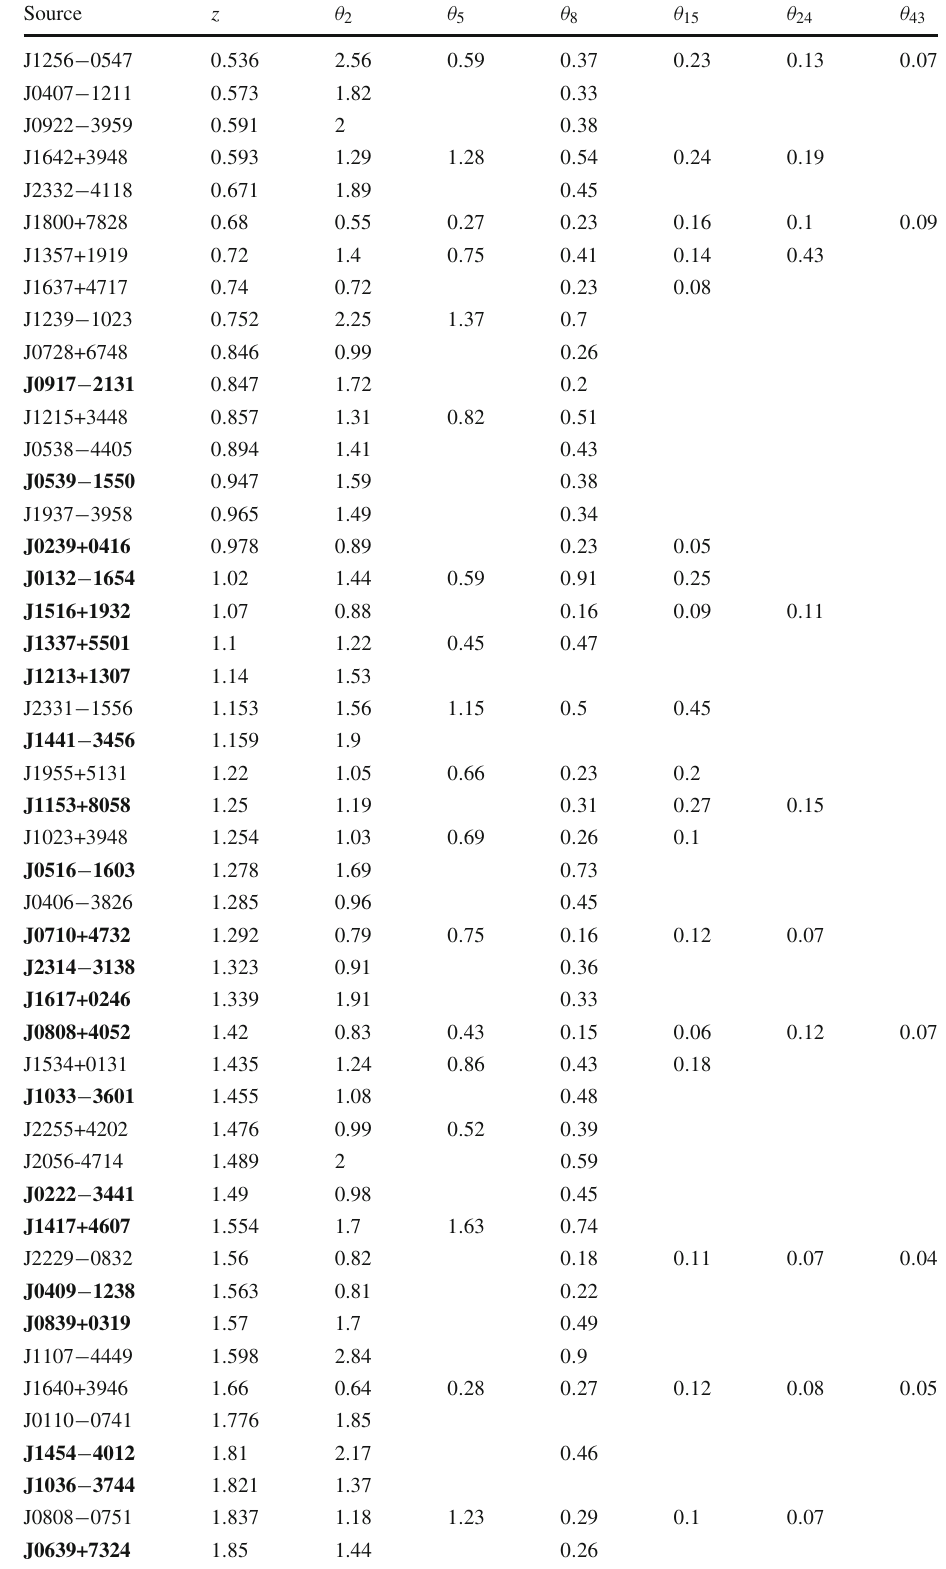
intermediate-luminosity quasars from Pushkarev and